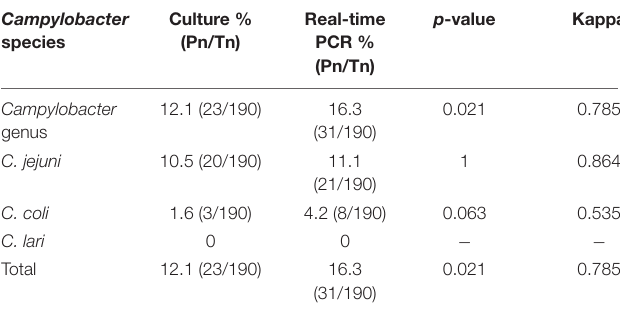
TABLE 3 | Comparison between culture and real-time PCR for Campylobacter detection.